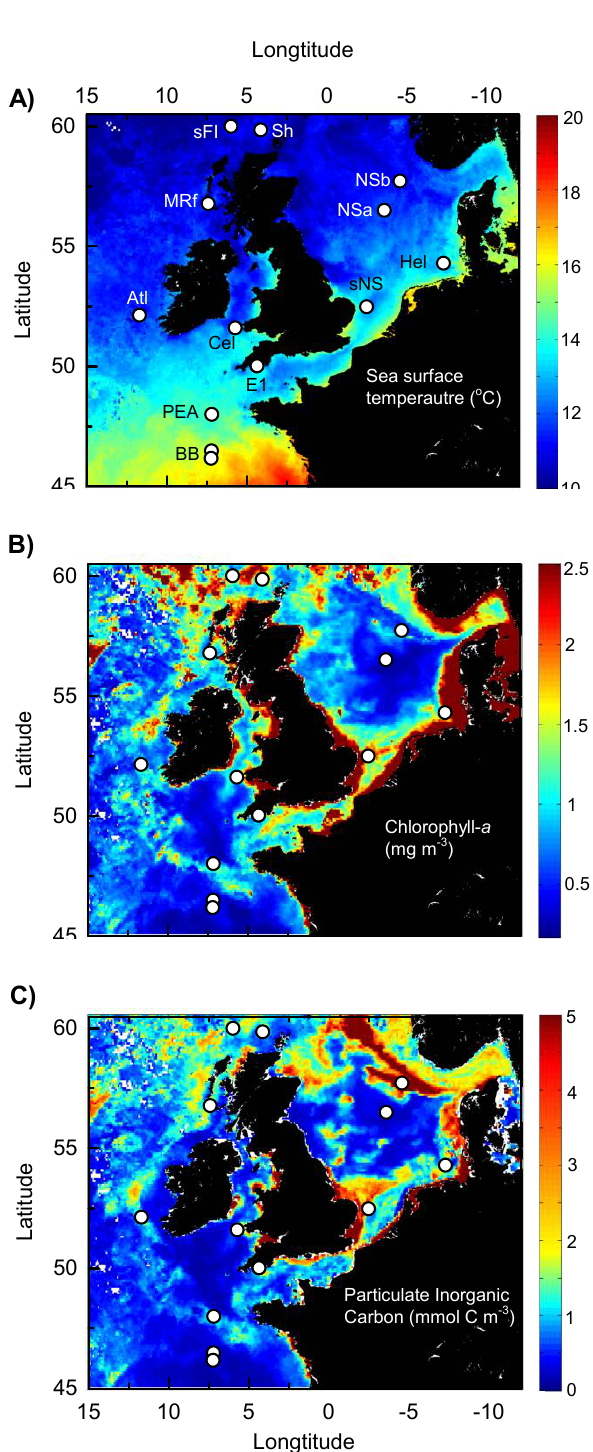
Figure 1. Maps showing the position of the daily productivity sam- pling stations (circles) and short-term (48h) experiments (squares), superimposed on MODIS composites (June 2011) of (A) sea sur- face temperature ( ◦ C), (B) surface chlorophyll a , (mgm − 3 ) and ( C ) surface particulate inorganic carbon (mmolCm − 3